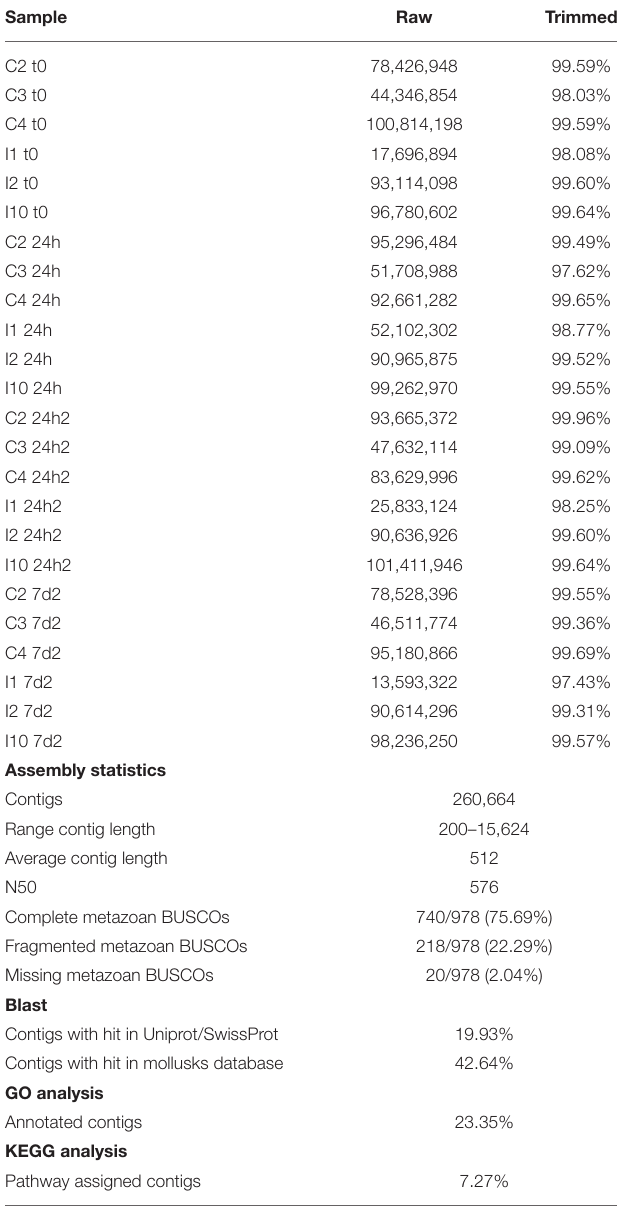
TABLE 1 | Summary of the transcriptome bioinformatics pipeline.